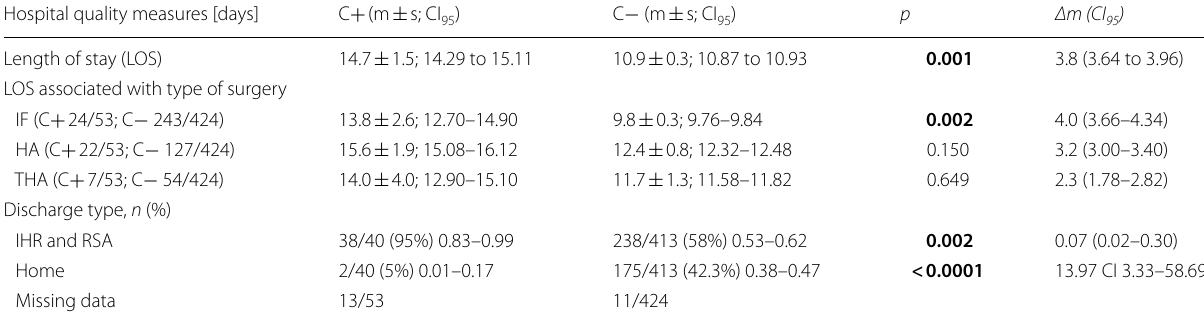
m: mean of the sample; s: standard deviation of the sample; CI 95 : confidence interval (95%); Δm: difference of the means (m C control group; see definitions in Materials and